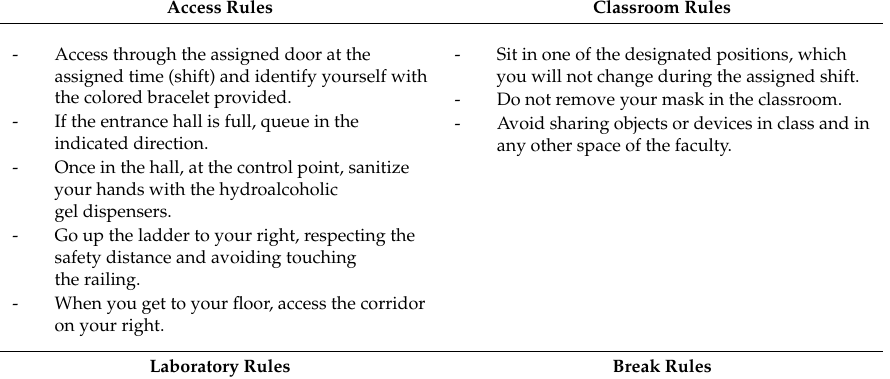
Table 8. Basic rules in the